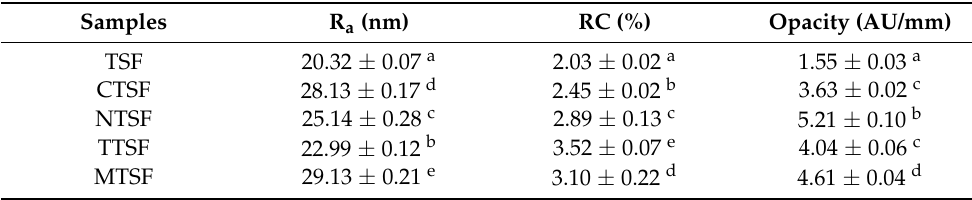
Figure 1. ( a ) Digital photographs and ( b ) scanning electron monographs of biodegradable composite films with and without plant extracts. Table 1. Roughness (R a ), relative crystallinity (RC), and opacity of biodegradable composite films with and without plant